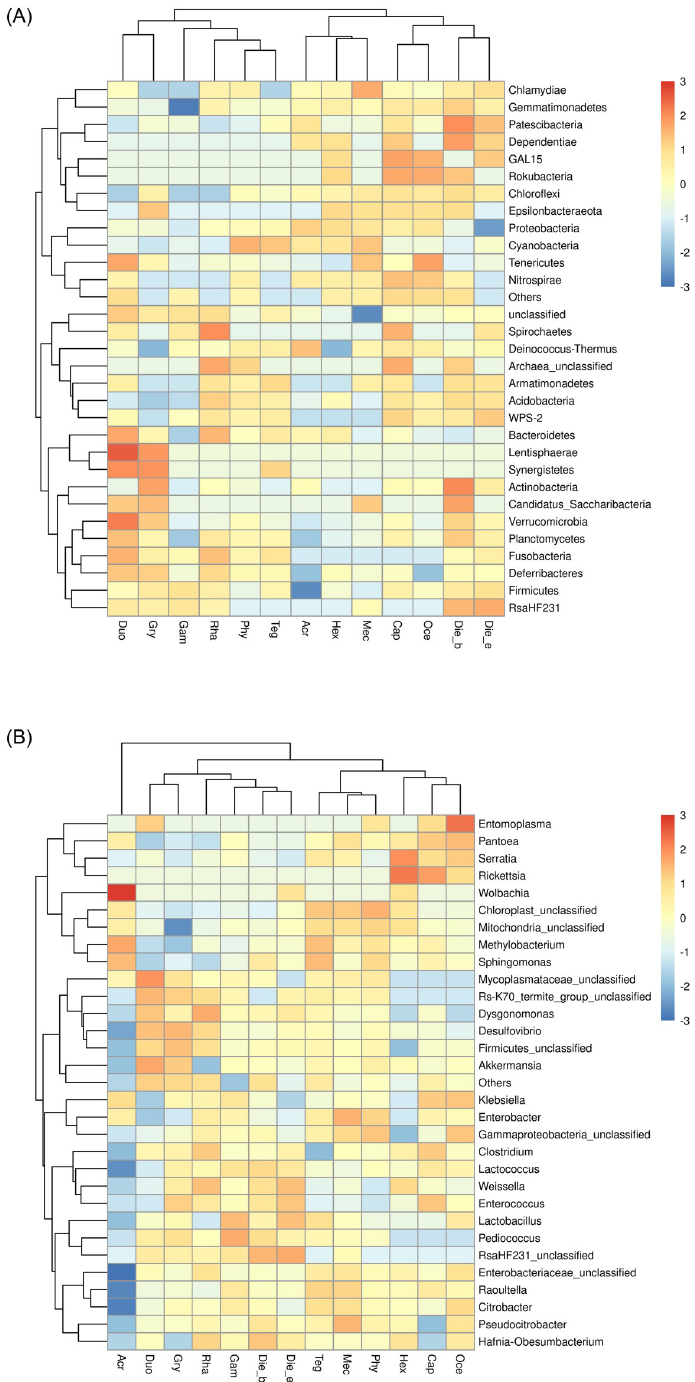
Fig 5. A clustered heatmap using the corresponding dendrogram illustrating the top 30 mean abundances of the bacterial community taxa assigned to phyla (A) and genera (B) level. The color scale of higher (red) and lower (blue) show the relative abundances of bacterial